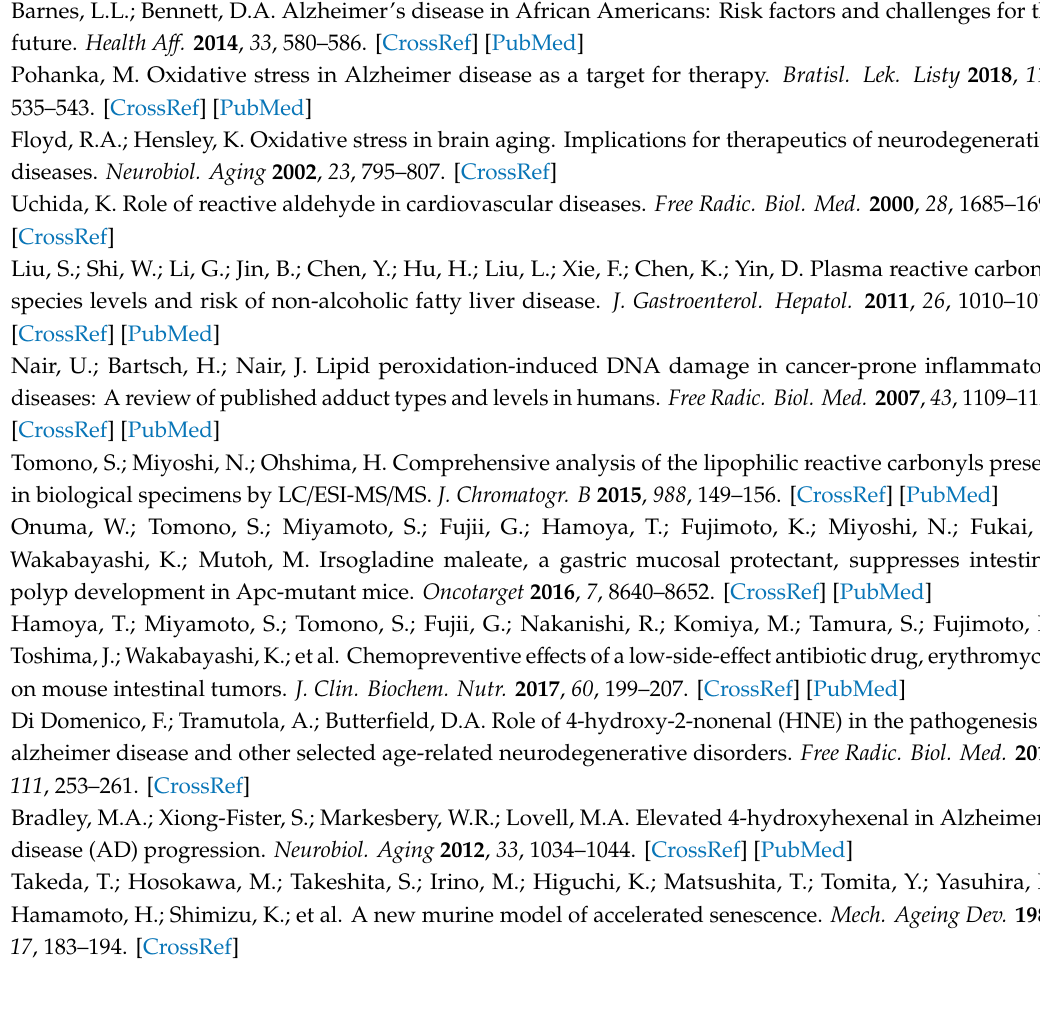
Figure S1: Reactive carbonyl species (RC) maps of livers obtained from SAMP10 mice in the young control, fed basal diet (YC), old control, fed basal diet (OC), old, fed basal diet supplemented with 0.02% sesame lignans (OS0.02), and old, fed diet supplemented with 0.05% sesame lignans (OS0.05). The area of each circle represents the intensity of the RCs relative to an internal standard. RC maps are presented as averages of each map ( n = 5); Table S1: Reactive carbonyl species (RCs) in cerebral cortices; Table S2: Reactive carbonyl species (RCs) in